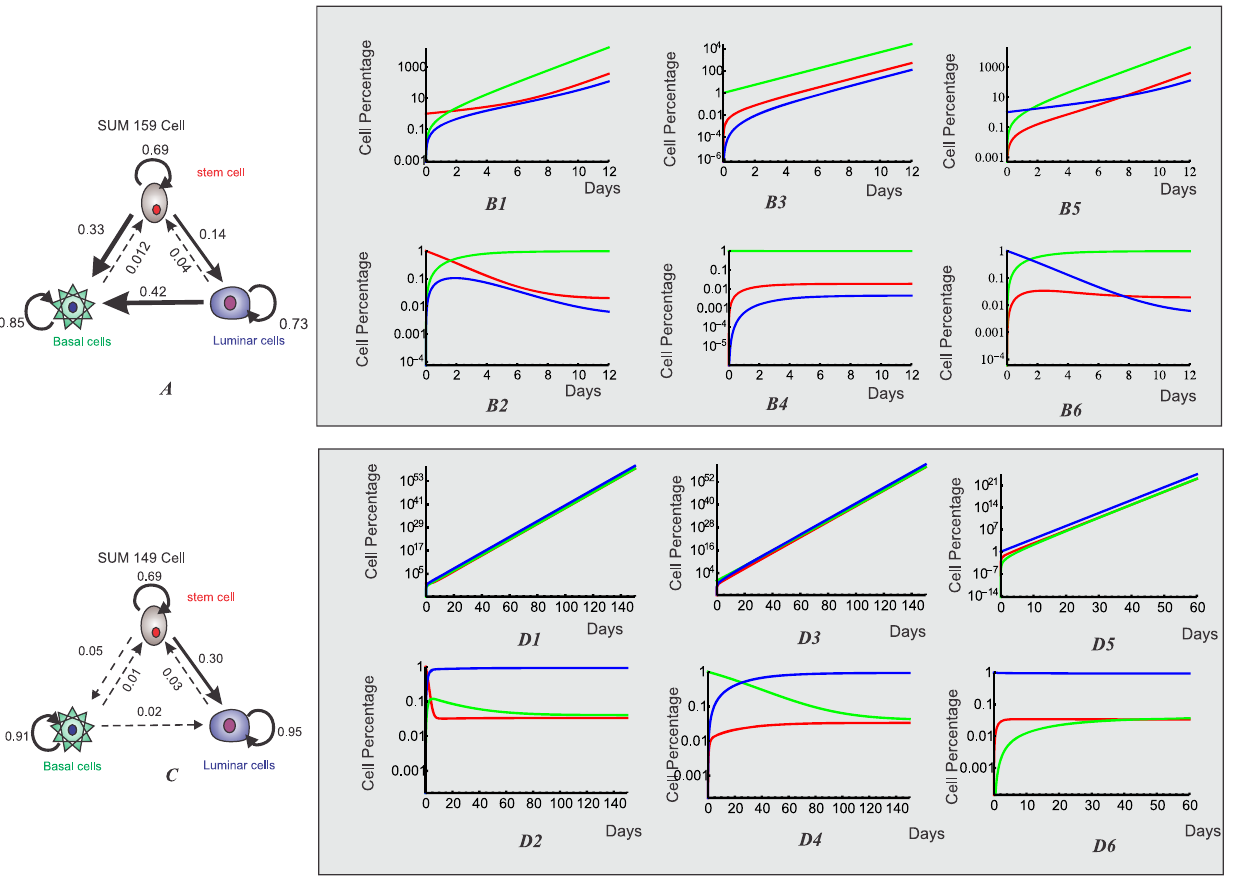
Figure 4. Three-phenotypic breast cancer cell population dynamics with both growth and transition from model simulation. A . Illustration of cell growth and transition for breast cancer cell line with three distinct cell phenotypes: luminal cell, basal cell and mammary stem cell. B1-B6 . After FACS sorting, each isolated subpopulation of cell line SUM159, stem-like, basal and luminal cells, re-equilibrate to the stable cell-state ratio r (cid:2) . Upper panels are the dynamics for cell numbers of three subpopulations; Lower panels are the dynamics for the cell ratios of three subpopulations. C1-C6 . After FACS sorting, each isolated subpopulation of cell line SUM149, stem-like, basal and luminal cells, re-equilibrate to the stable cell-state ratio r (cid:2) . Upper panels are the dynamics for cell numbers of three subpopulations; Lower panels are the dynamics for the cell ratios of three subpopulations.